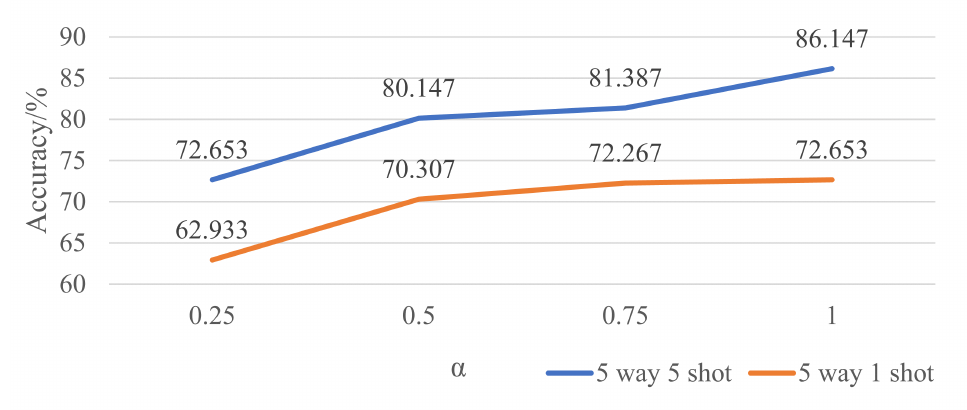
Figure 11. Experiments on extra loss from contrastive loss against α in both five-way one-shot and five-way five-shot